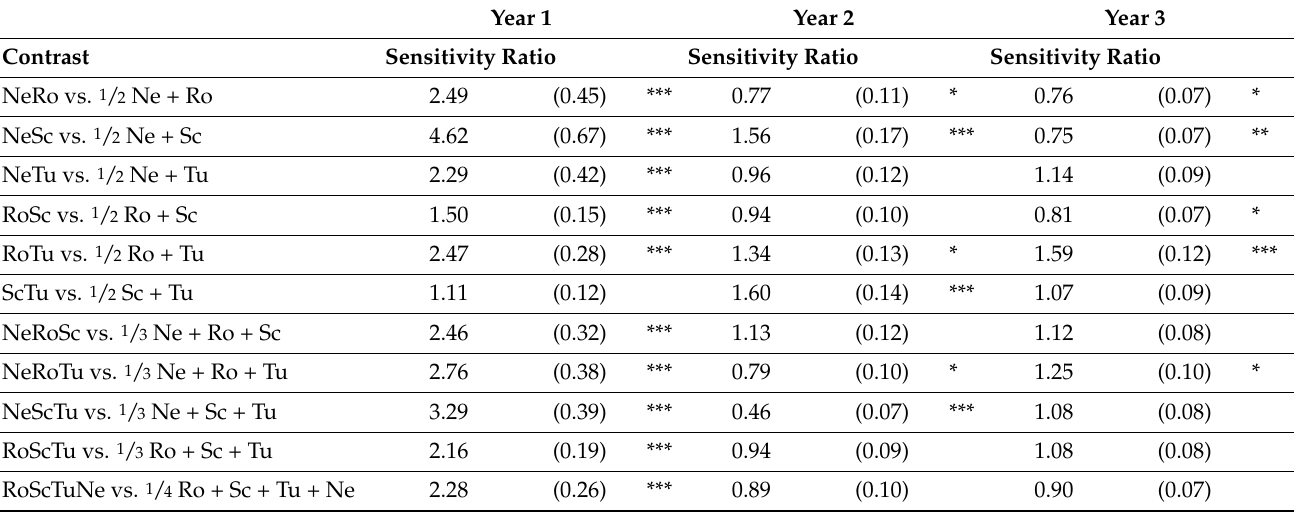
Table 2. Results of orthogonal contrasts for weed biomass for all lentil mixtures in the three experi- mental years; expressed as sensitivity